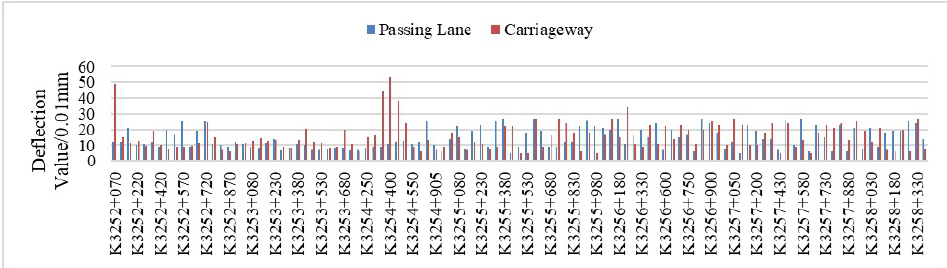
Fig. 1 Distribution of deflection value in K3139 + 200 ∼ K3202 + 500 section.